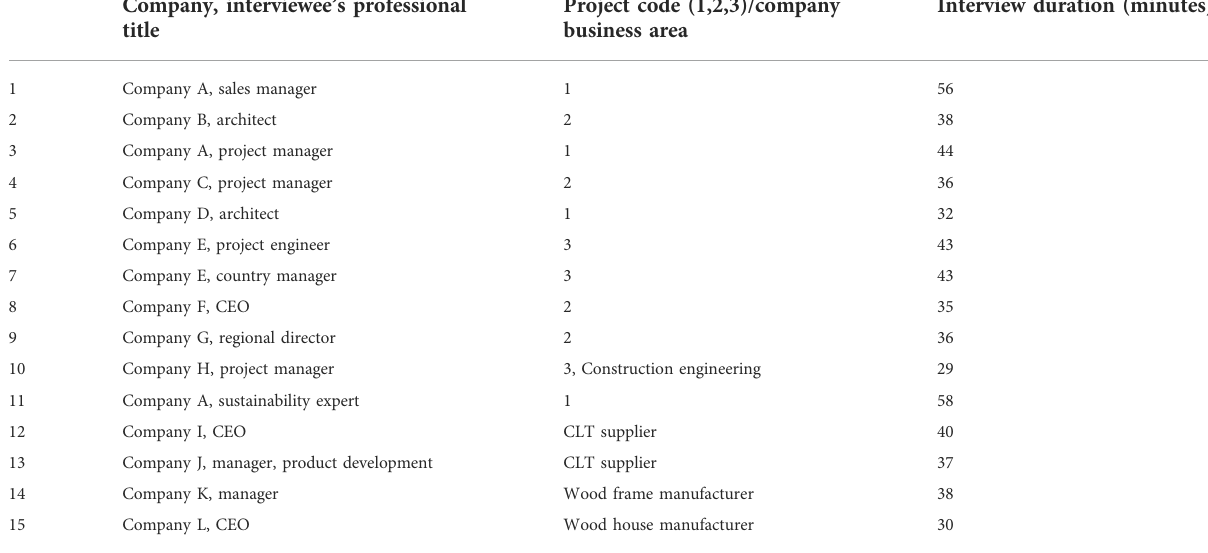
TABLE 1 Companies and individuals involved in the interviews during October 2021 – March 2022, and interview